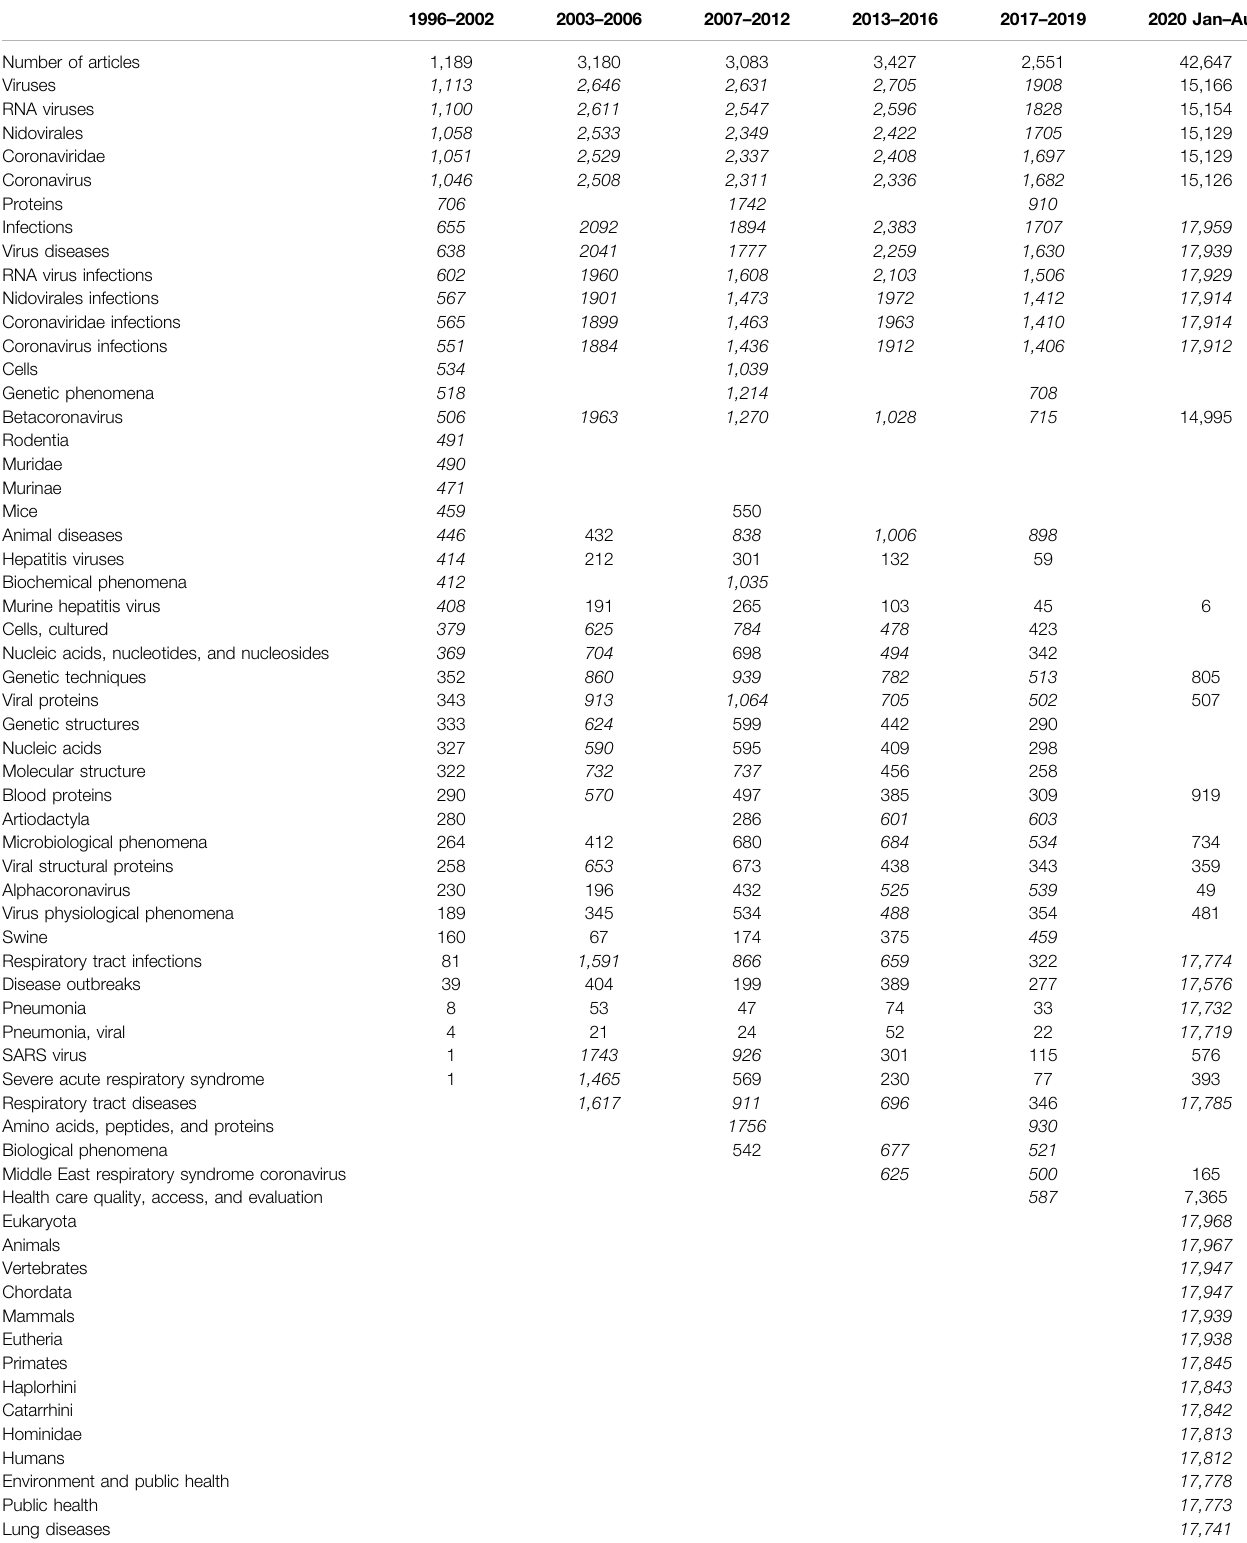
TABLE 1 | Top 25 unique keywords in coronavirus research